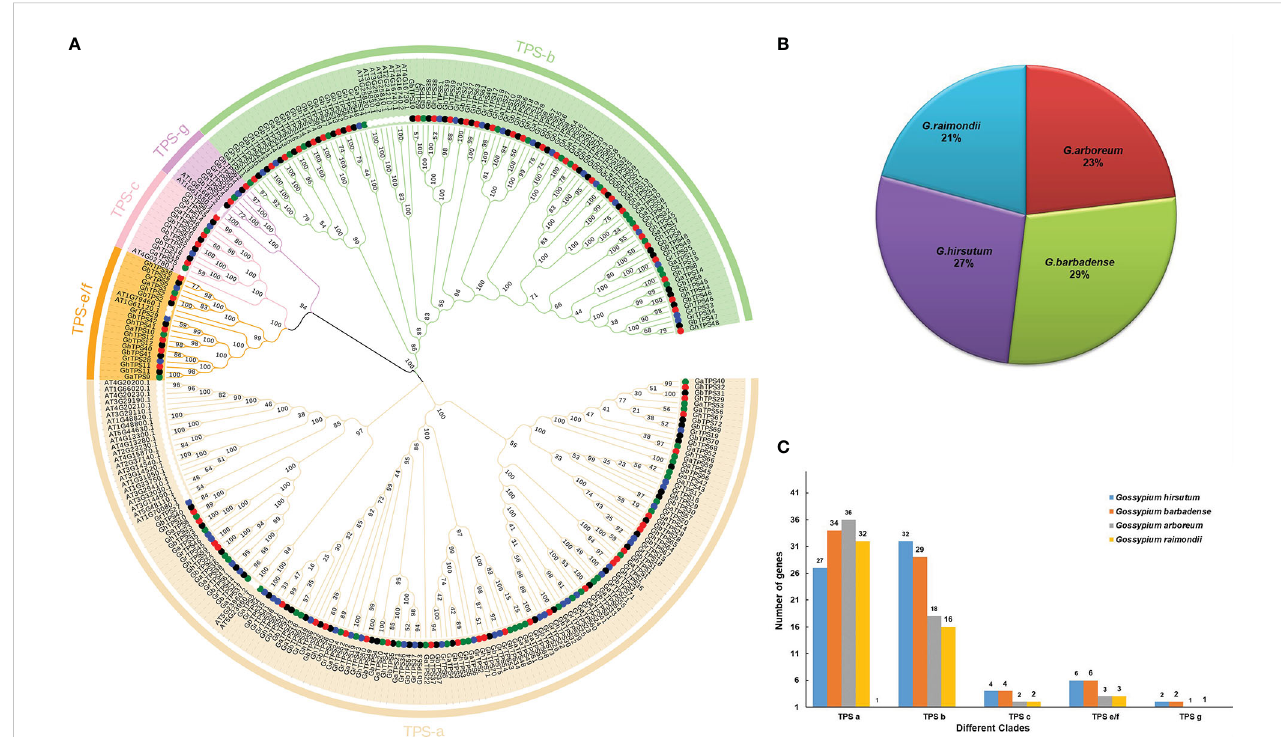
FIGURE 1 TPS gene family phylogenetic tree. (A) Phylogenetic relationships of 298 TPSs in fi ve species. (B) The proportion of different cotton species in 260 TPS genes. (C) Distribution of gene number in fi ve evolutionary clades. Different colors represent different